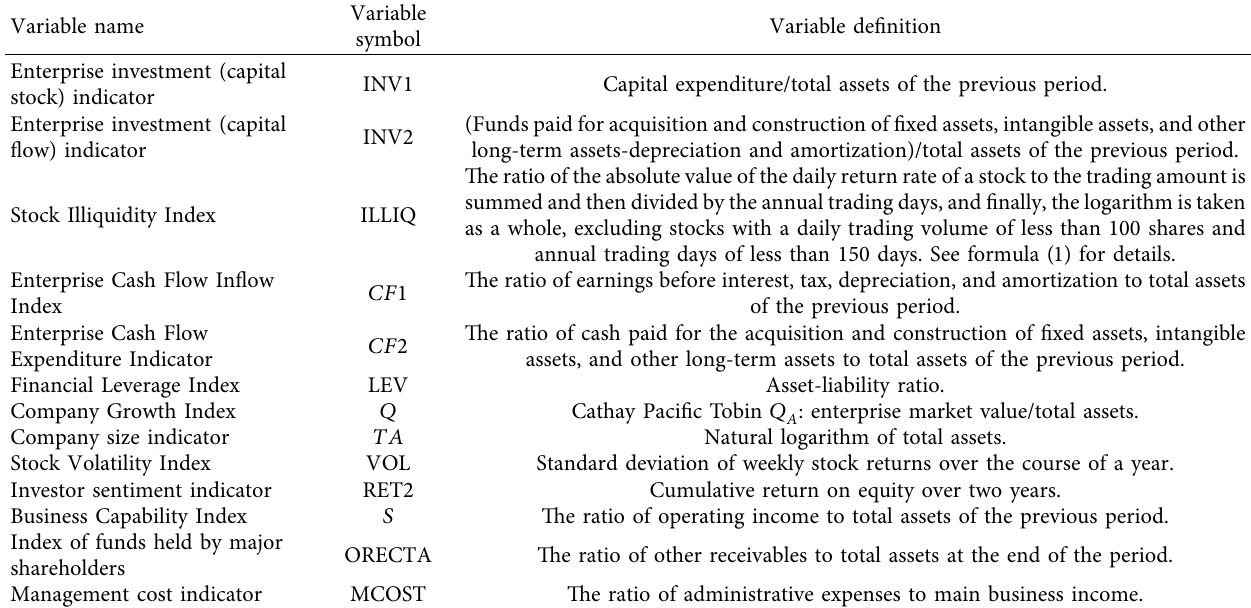
Table 1: Variable